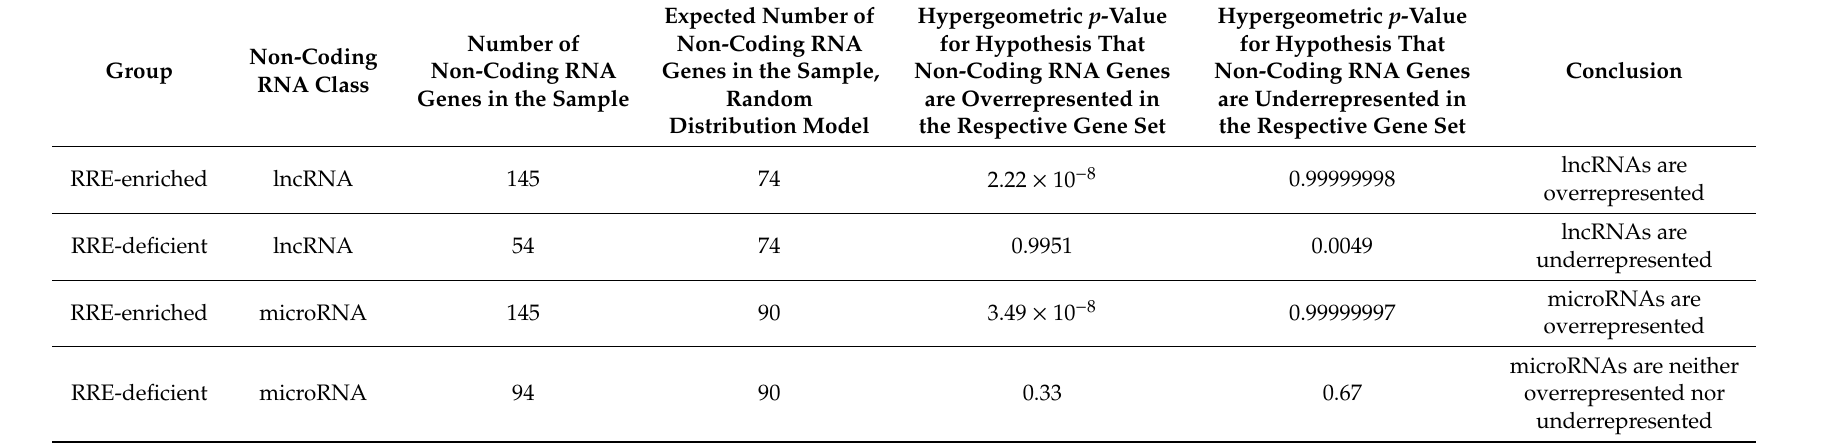
Table 1. Analysis of human non-coding RNA RE-linked